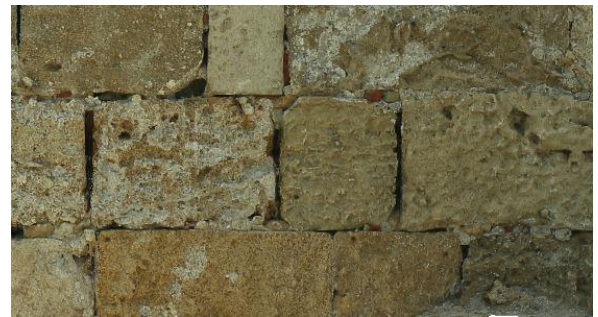
Figure 4 . Detailed 3D Textured Model (RGB).